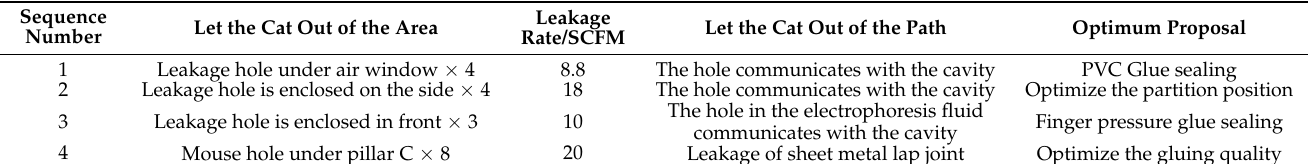
Table 9. The sealing scheme of the cab.